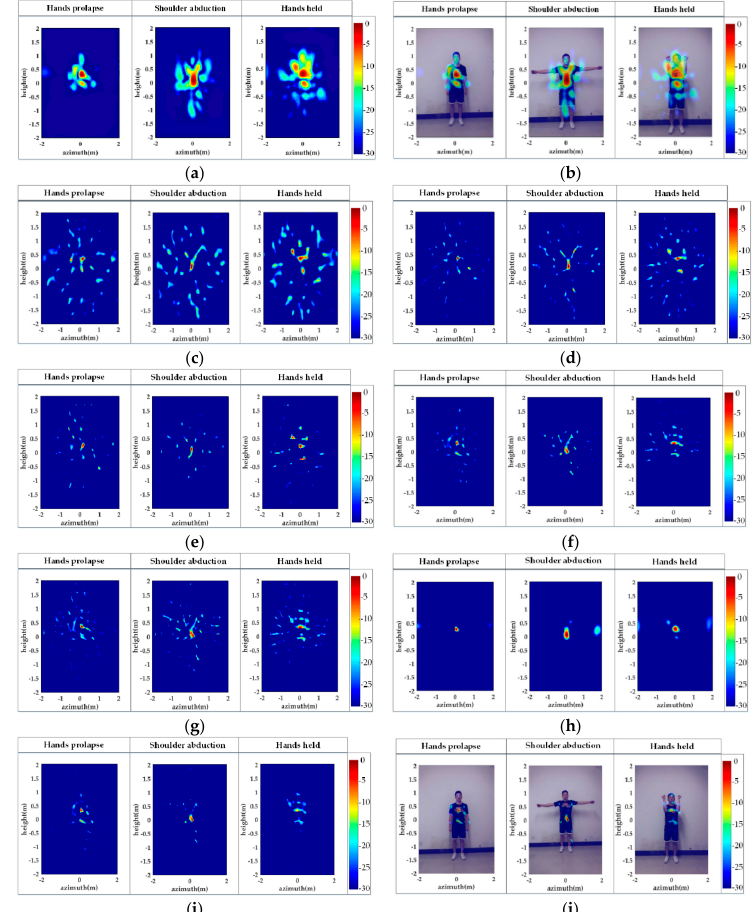
Figure 10. ( a ) BP imaging result; ( b ) Registration figure for BP imaging; ( c ) Enhanced imaging result with Wiener filtering; ( d ) Enhanced imaging result with Tikhonov regularization; ( e ) Enhanced imaging result with TM regularization; ( f ) Enhanced imaging result with LR algorithm; ( g ) Enhanced imaging result with LRMER algorithm; ( h ) CF weighted method; Enhanced imaging result with LRTV algorithm; ( i ) Enhanced imaging result with LRTV algorithm; ( j ) Registration figure for LRTV algorithm.